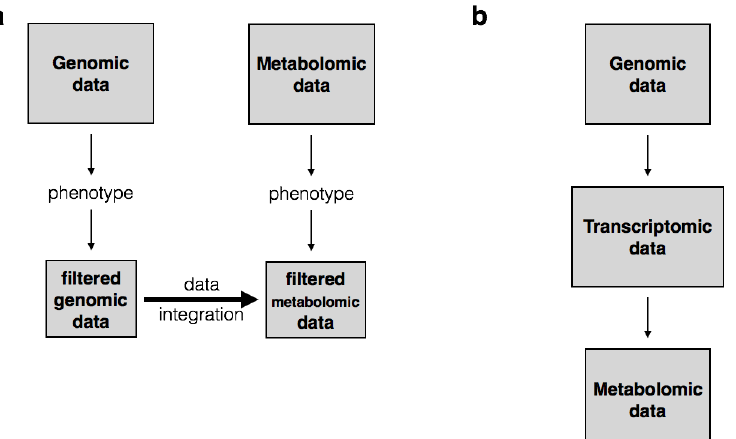
Figure 2. Examples of a multi-stage integrative analysis approach. Example ( a ) illustrates a three-step framework where genomic and metabolomic datasets are concurrently tested for association with the phenotype resulting in smaller datasets. These datasets are then investigated to infer linked variables. Example ( b ) illustrates a typical scenario where genomic variables are tested for association with transcripts which are in turn associated with metabotypes. These metabotypes might for instance explain the expression of a given phenotype. These models are useful for vertical data integration but not suitable for meta-analysis since they assume that different omics entities are